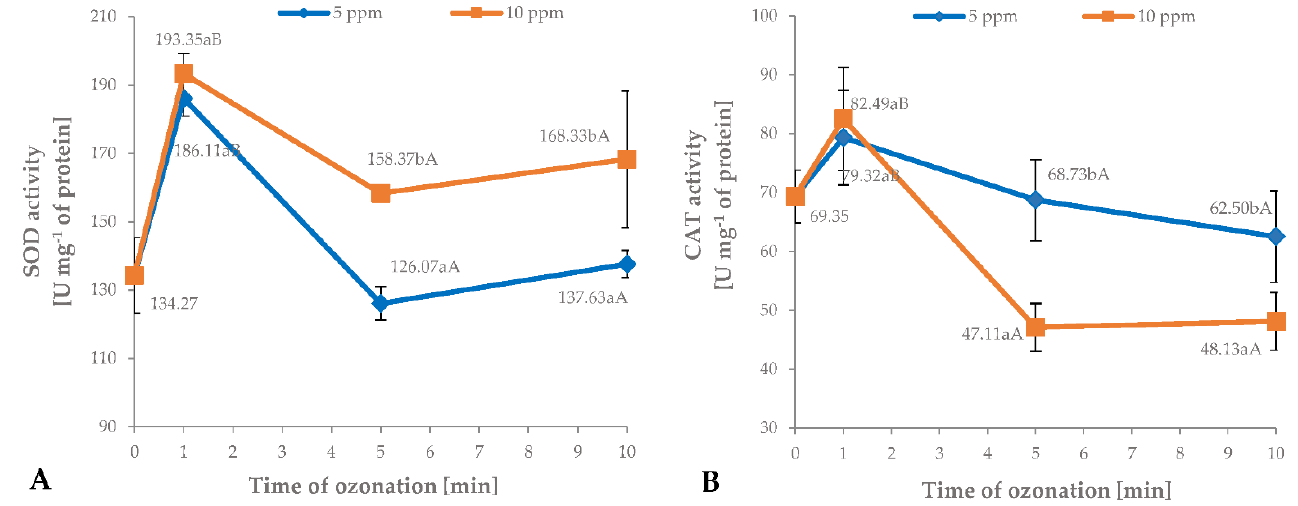
Figure 5. SOD ( A ) and CAT ( B ) activity in Kalanchoe daigremontiana leaves depending on the duration of ozone treatment (n = 20): differences between the results for duration of ozone treatment on specific days are marked with small letters, and differences between dose of ozone (ppm) measurements are marked with capital letters; significance level is defined as p < 0.05.